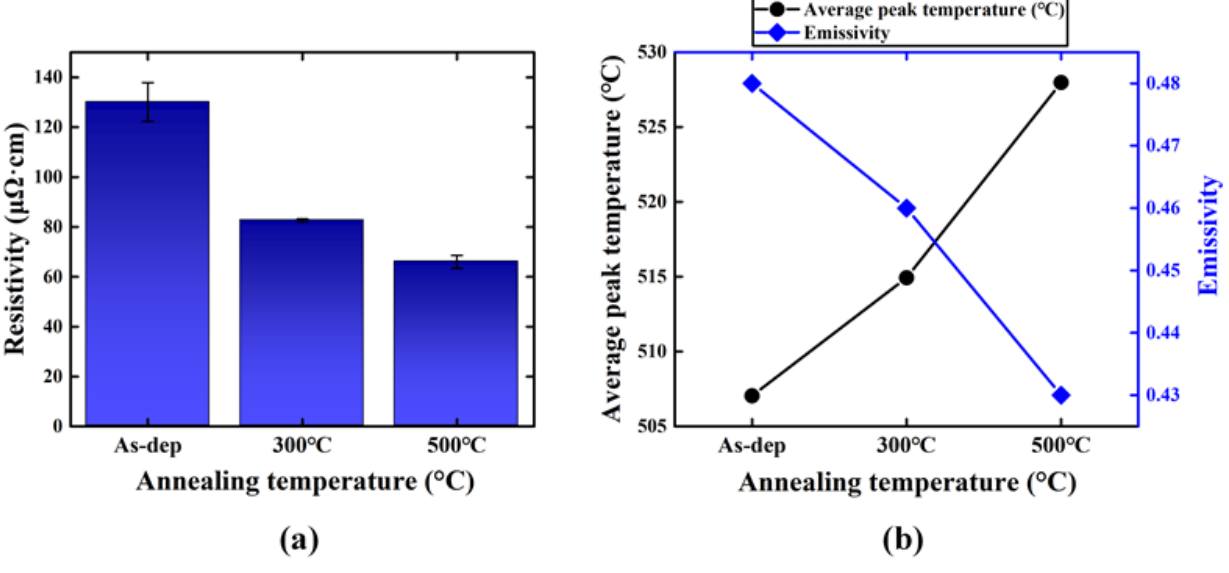
Figure 7. ( a ) Resistivity, and ( b ) peak temperature measured from the heat load test and calculated emissivity of the Ru/SiN x pellicle composite: As deposited, after 300 ◦ C annealing, and after 500 ◦ C annealing.